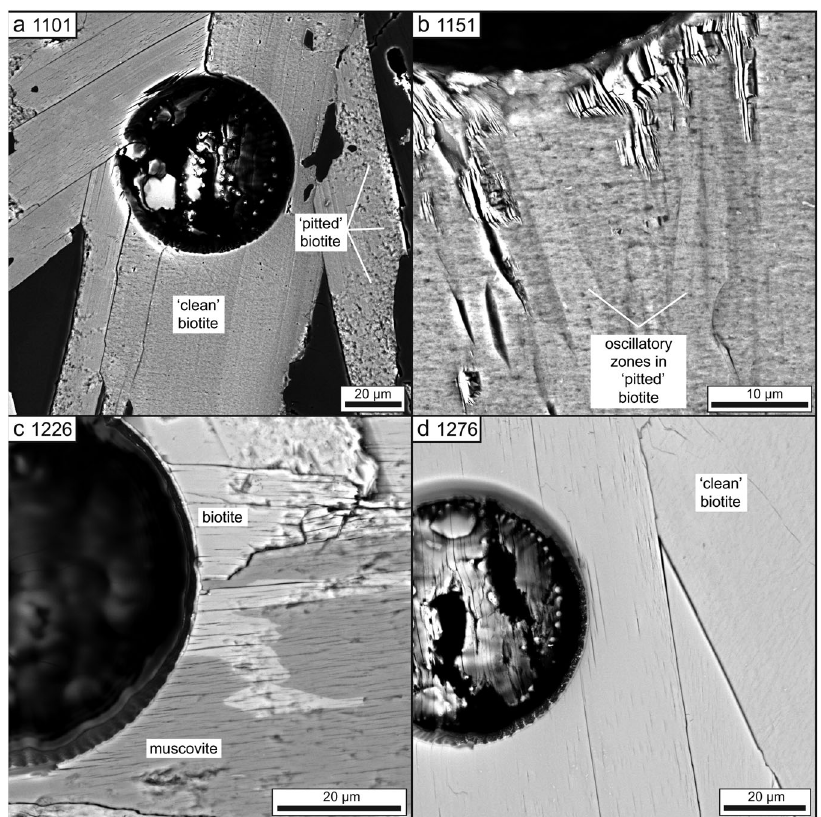
Fig. 4 Representative backscatter electron images of mica grains. Different mica grains within samples analyzed for Rb – Sr geochronology with various portions of laser ablation sample pits are shown. Each representative image contains the corresponding sample number in the upper left of each panel.